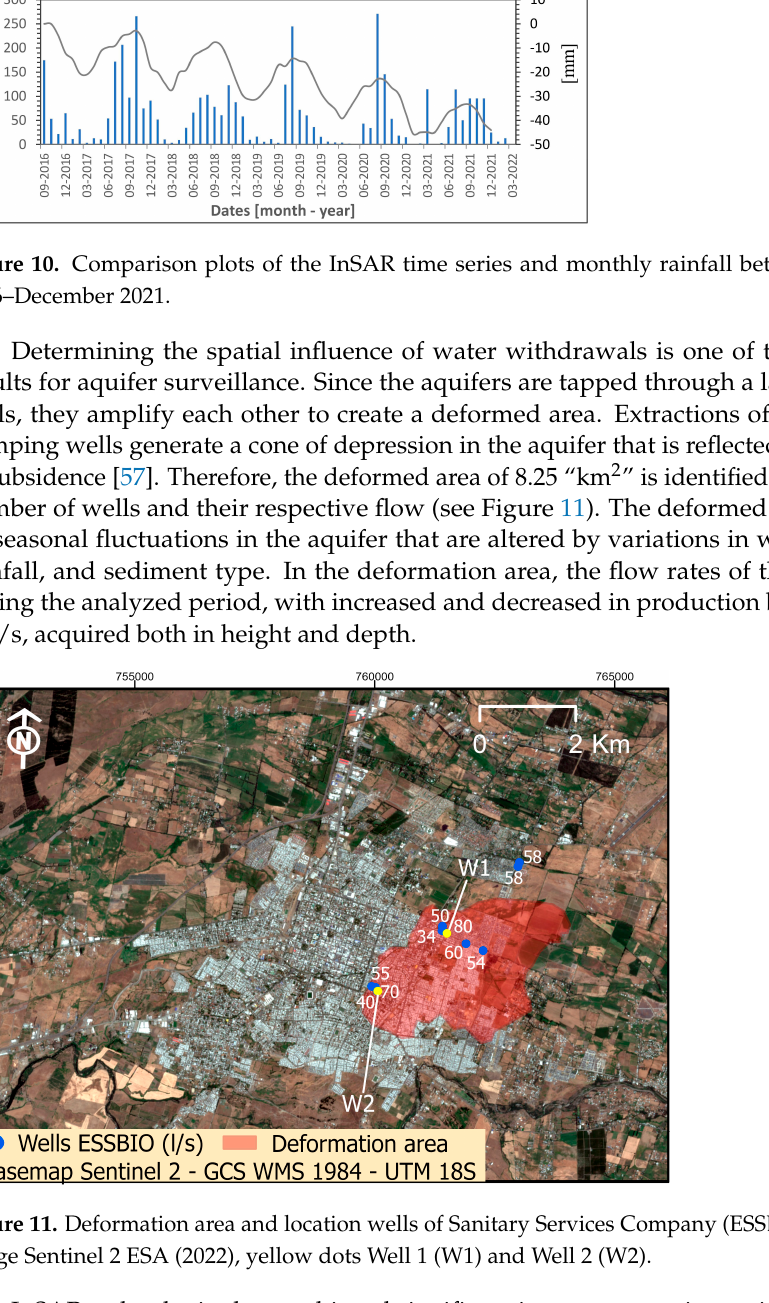
Figure 12. Groundwater level and LOS SAR time series, (a) SL1 and PSI1 for Well 1 (W1), and (b) SL2 and PSI2 for Well 2 (W2).